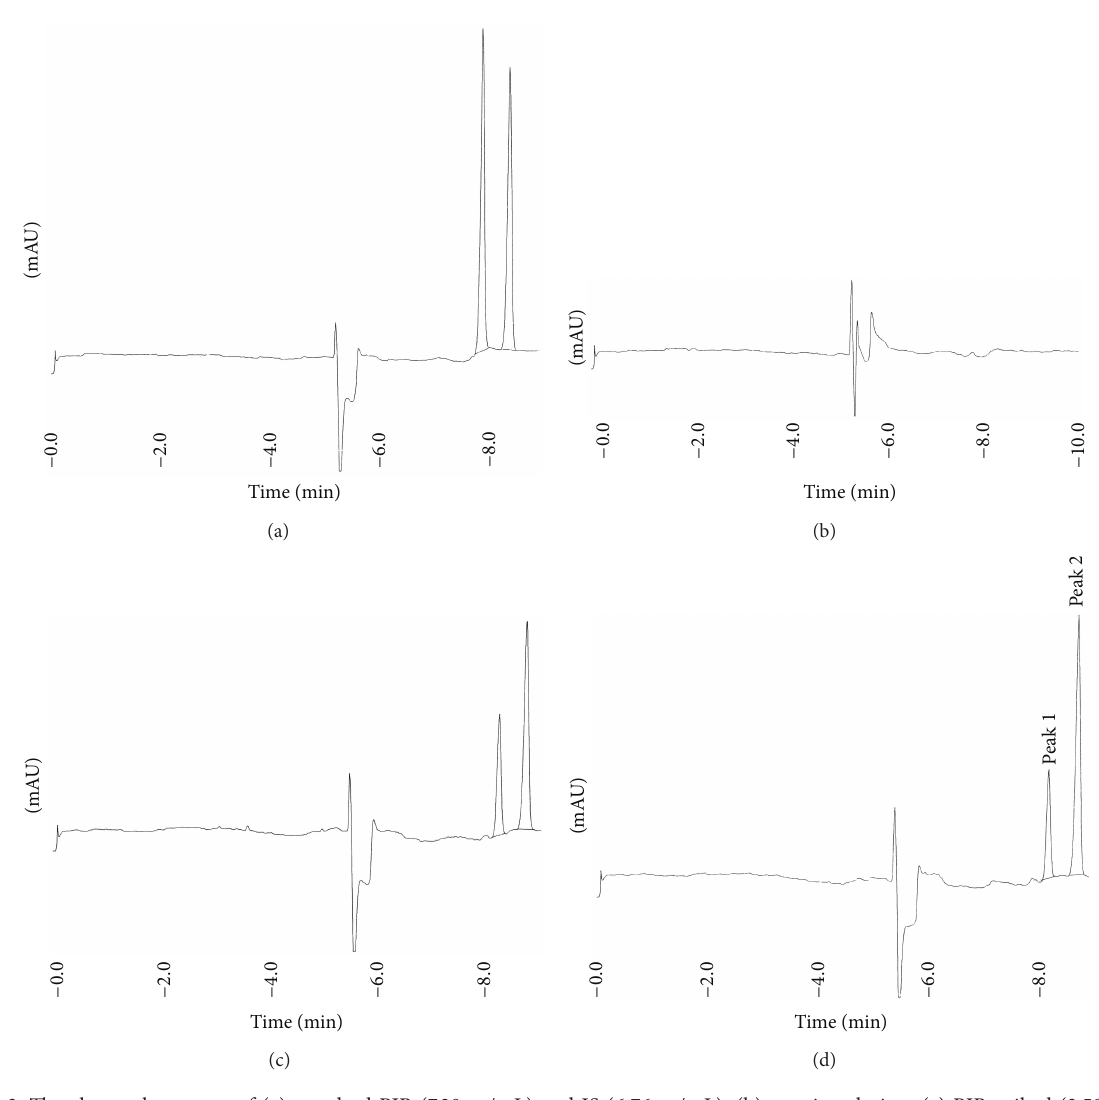
Figure 2: The electropherogram of (a) standard PIR (7.20 𝜇 g/mL) and IS (6.76 𝜇 g/mL), (b) matrix solution, (c) PIR spiked (2.58 𝜇 g/mL) matrix solution (IS 6.76 𝜇 g/mL), and (d) tablet solution containing PIR (2.58 𝜇 g/mL) (IS 6.76 𝜇 g/mL). Peak 1 is piroxicam (PIR); peak 2 is naproxen sodium (NAP) as internal standard